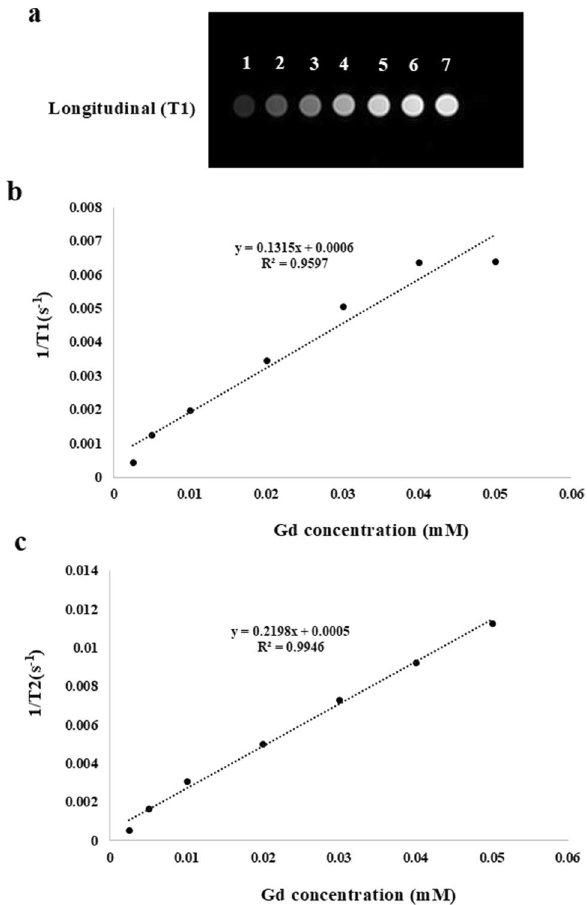
Figure 8. ( a ) T1-weighted magnetic resonance phantom images of Gd-doped CQDs; the samples 1–7 correspond to the Gd concentrations of 0.0025, 0.005, 0.01, 0.02, 0.03, 0.04, 0.05 mM, respectively. ( b ) The linear relationship between r1 and Gd concentration, ( c ) Linear relationship between transverse relaxivities (r2) and Gd